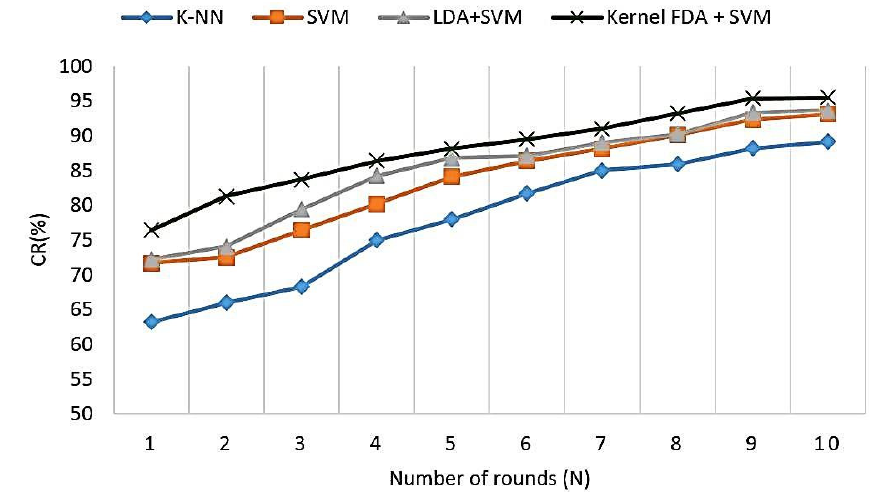
Figure 8. P300 classification rates of different methods.